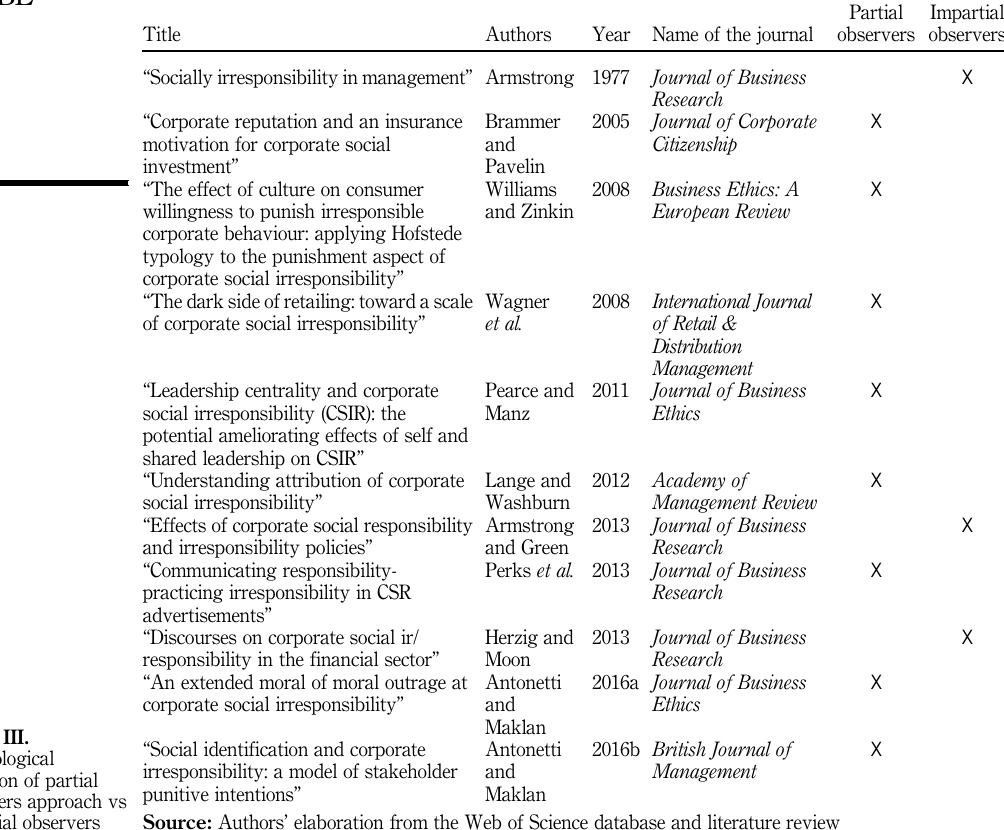
evolution of partial observers approach vs impartial